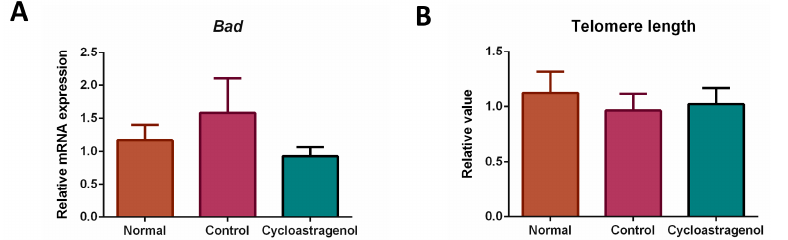
Figure 8. Effects of cycloastragenol (200 mg/kg) on the markers of senescence in the liver of mice treated with carbon-tetrachloride. Relative Bcl2-associated agonist of cell death ( Bad ) mRNA expression ( A ) and telomere length of genomic DNA ( B ) when compared with the normal are shown. Bar graphs and corresponding error bars indicate means and SEM among the same treatment, respectively ( n = 8–10).